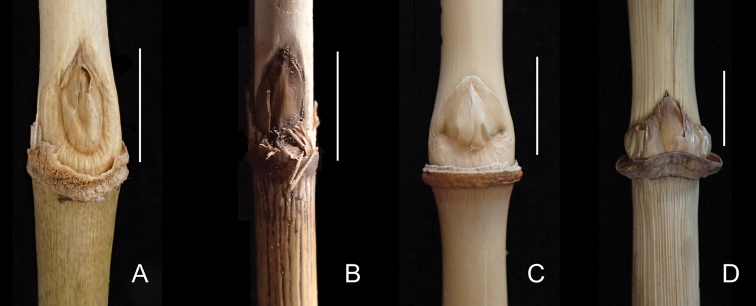
Comparison of buds AKhoonmengia
honbaensis, showing elliptic bud wholly sunken into culm (From N. H. Xia et al. BVN2017048) BHsuehochloa
calcarea, showing elliptic bud wholly sunken into culm (From Y. Y. Zhang zyy-030, IBSC) CAmpelocalamus
actinotrichus, showing ovate bud with the base sunken into culm (From N. H. Xia et al. HN-025, IBSC) DAmpelocalamus
melicoideus, showing broad ovate bud not sunken into culm (From Y. Y. Zhang zyy-033, IBSC). Scale bars: 1 cm (A, C, D); 5 mm (B).